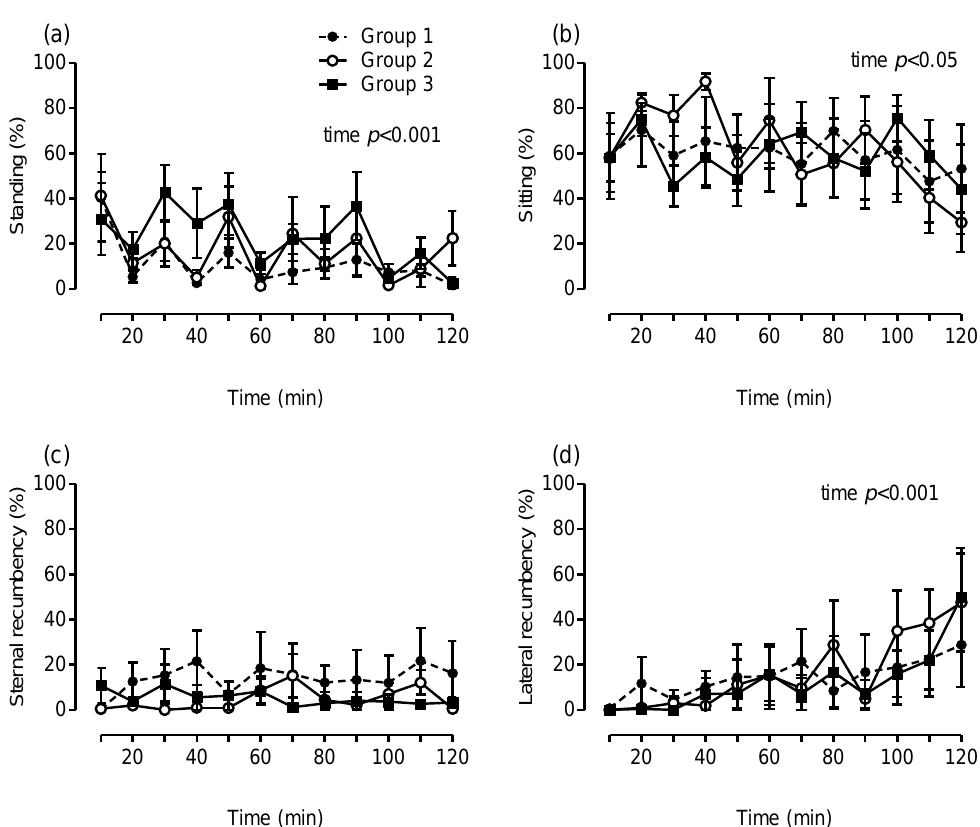
Figure 6. Time spent ( a ) standing, ( b ) sitting, ( c ) in sternal recumbency and ( d ) in lateral recumbency in dogs differing in transport experience transported for two hours ( n = 6 per group). Times are given as percentage for each position for subsequent 10-min intervals. Values are means ± SEM, significant differences are indicated in the figures.